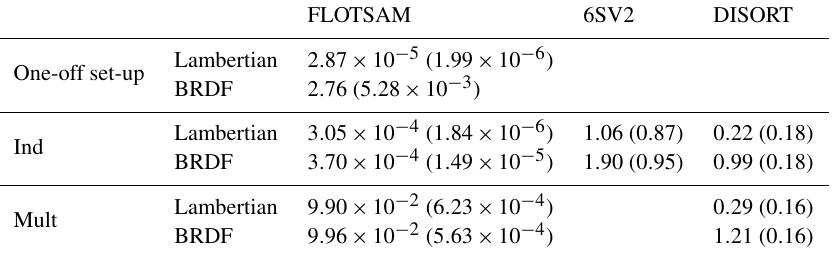
Table 5. Average runtimes in seconds. The standard deviation is shown in parentheses. The mult runtimes account for 640 profiles for FLOTSAM, 20 profiles for DISORT, and 1 profile per model call for 6SV2. The one-off set-up costs of FLOTSAM are invoked only once per instance of the executable, no matter how many radiances are subsequently calculated, so are the same for the ind and mult